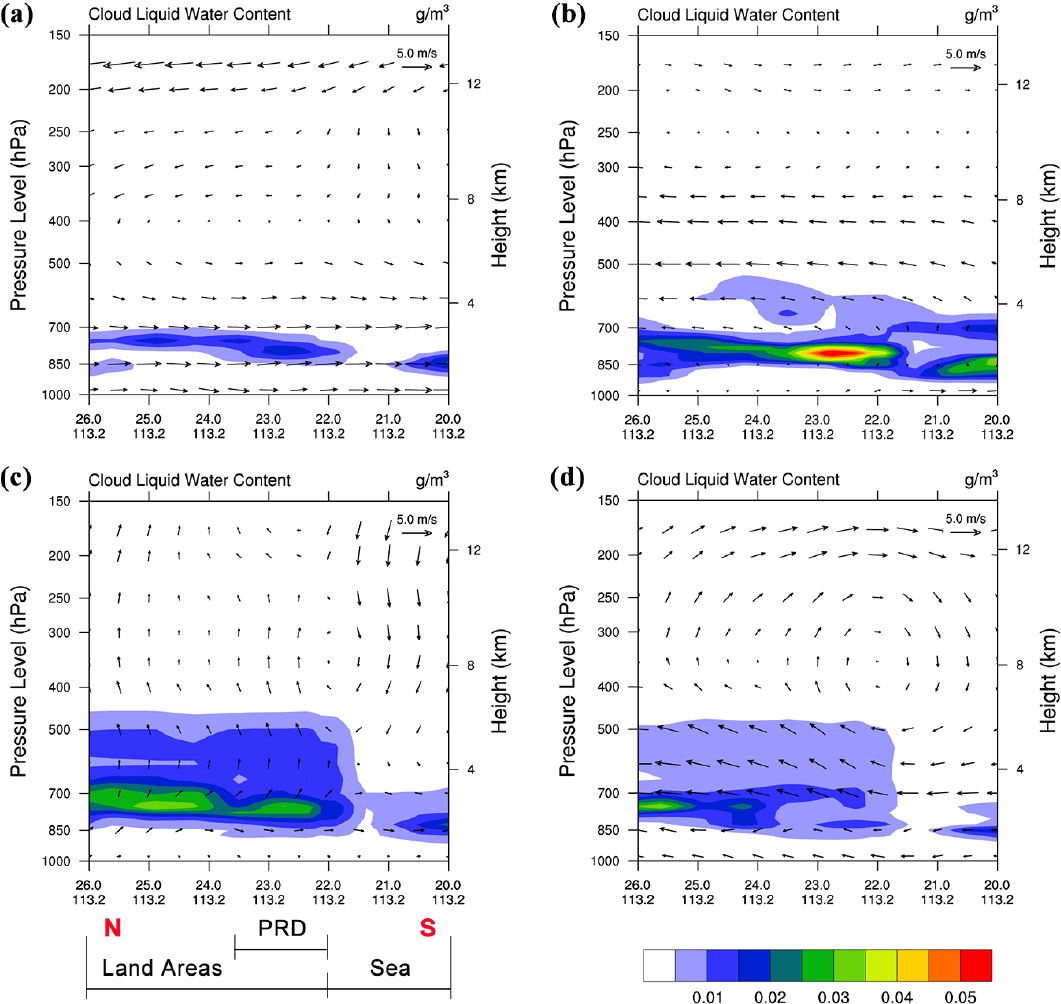
Figure 6. The cross sections of mean cloud liquid water content (grams per cubic metre; hereafter gm − 3 ) and wind vectors at 14:00LT for each scenario, i.e. (a) autumn (typhoon-induced), (b) autumn (no-typhoon), (c) summer (typhoon-induced) and (d) summer (no-typhoon). Cross sections were made along the 113.2 ◦ E longitude line, from 26.0 to 20.0 ◦ N (Fig. S4). The vectors indicate meridional wind speed (ms − 1 ) and vertical wind speed (cms − 1 ). PRD is the Pearl River